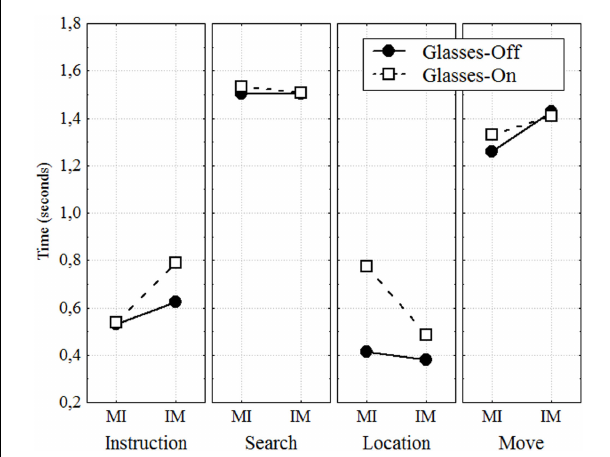
FIGURE 3 | Gaze Effects. Distributions of durations of the four different phases of the interaction with gaze blocked by Glasses (glasses-on), or not (glasses-off). During the Location phase when the Informer is wearing glasses, the manipulator’s response time is significantly